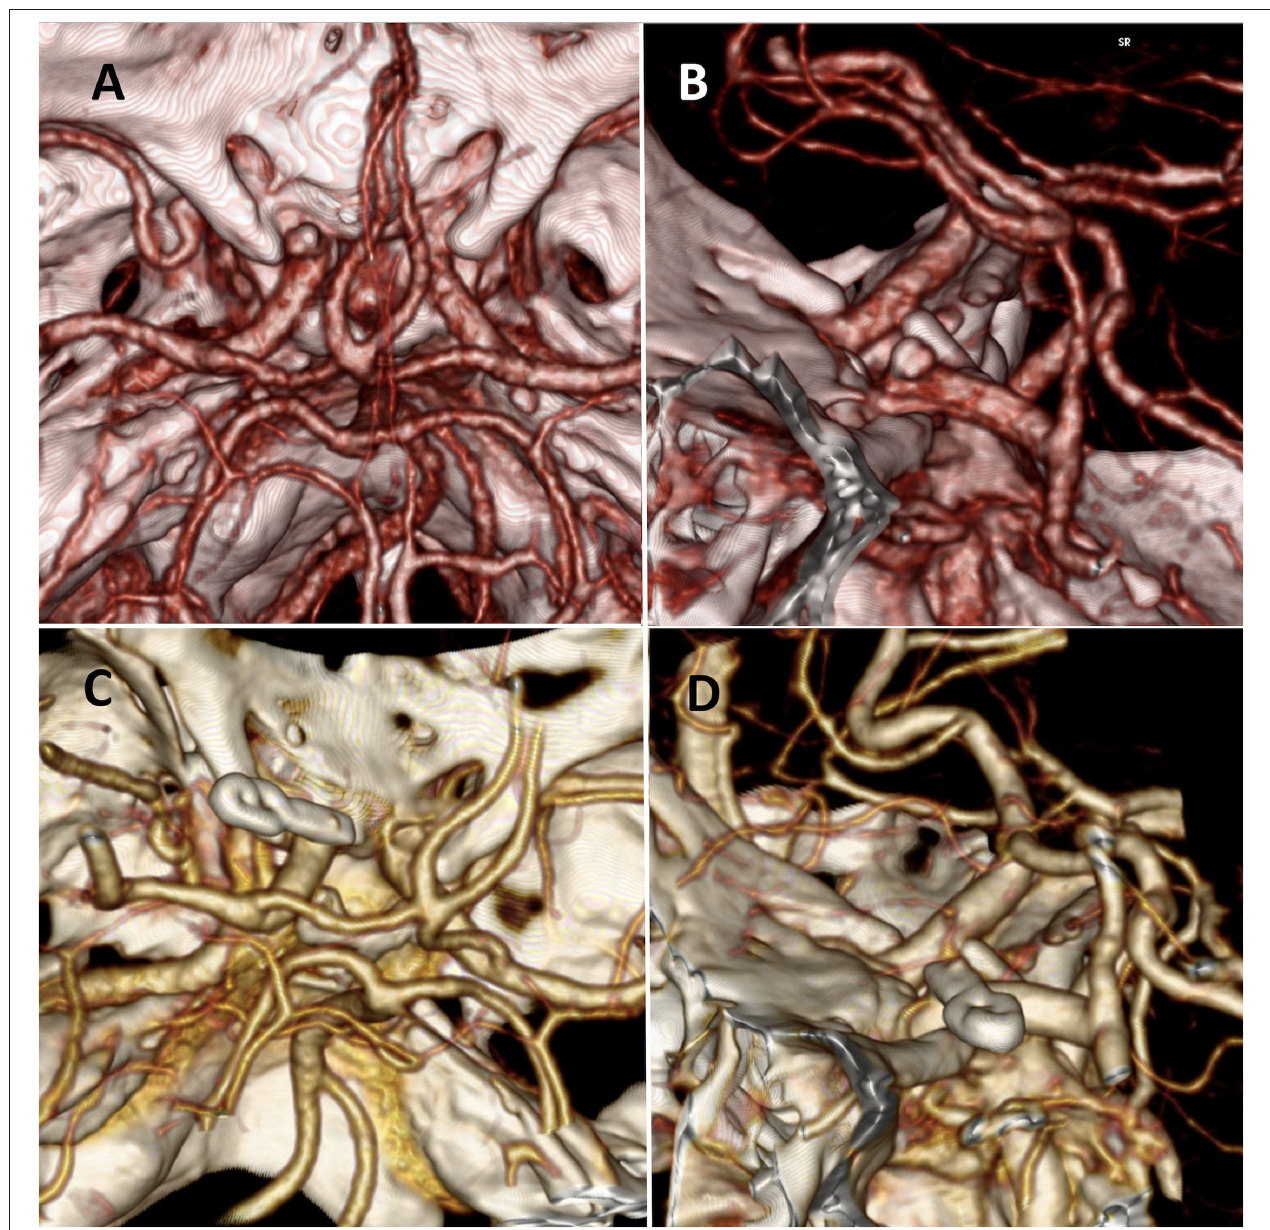
FIGURE 2 | (A,B) Preoperative CT angiography reconstruction of case 1 where we can observe a left superior carotid-ophthalmic aneurysm. (C,D) Postoperative CT angiography reconstruction with and excluded aneurysm after clipping.